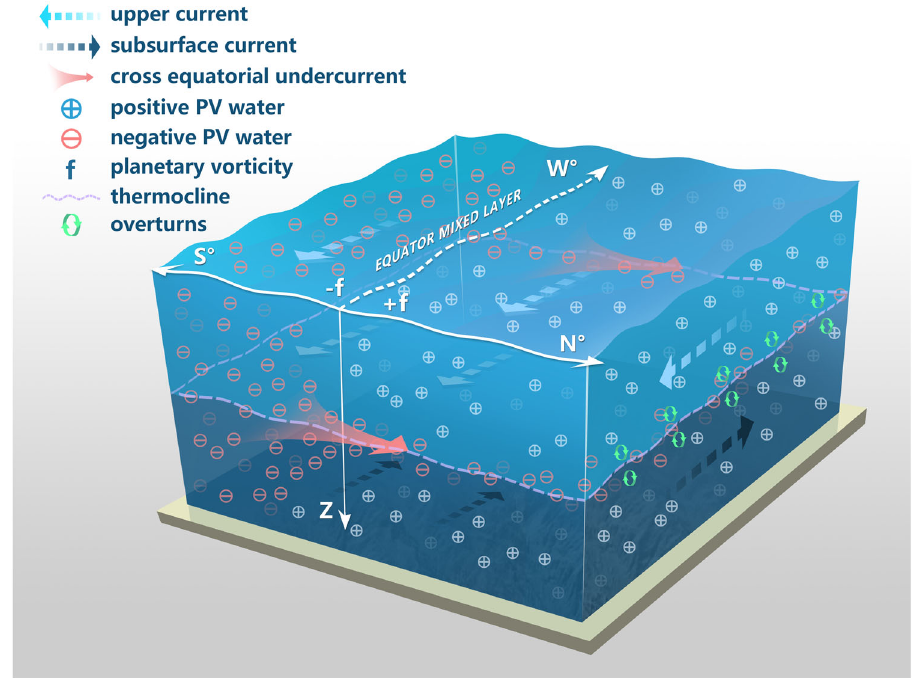
Fig. 8 Schematic diagram of the generation of subsurface symmetric instability induced turbulent mixing in the equatorial ocean interior. The opposite directions of surface and subsurface currents provide the strong shear, and the cross-equatorial undercurrent provides the negative potential vorticity water, satisfying the necessary condition of overturns associated with symmetric instability. The axis W means westward, N means northward, S means southward, and Z means